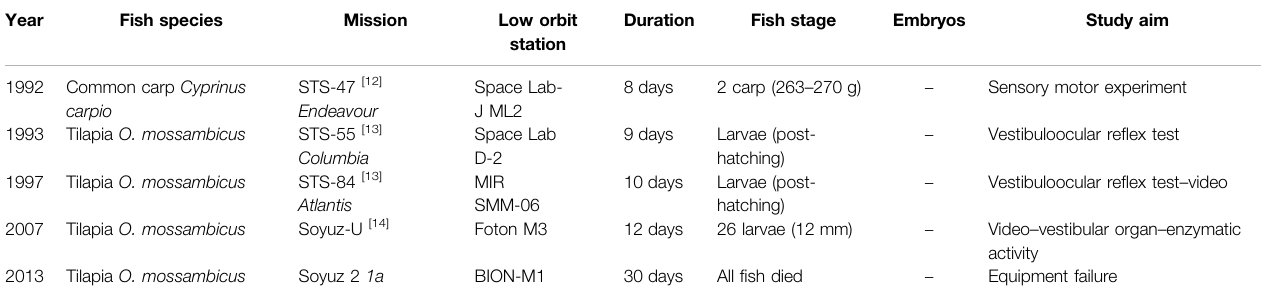
TABLE3| Studiesofaquaculture fi shasmodelsforsensorymotor,re fl exexperimentsandtrophicchaindemonstrationsinloworbitmissions.Referencestomajormissions are noted with numbers in brackets: [12] Mori, 1994 [13] Sebastian, 2001 [14] Anken,